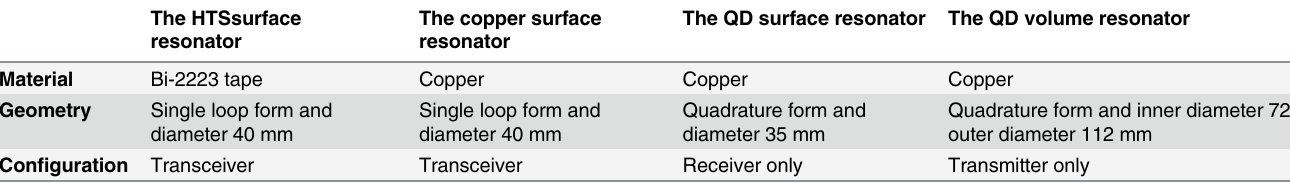
Table 1. General specification of the HTS, copper, QD surface and QD volume